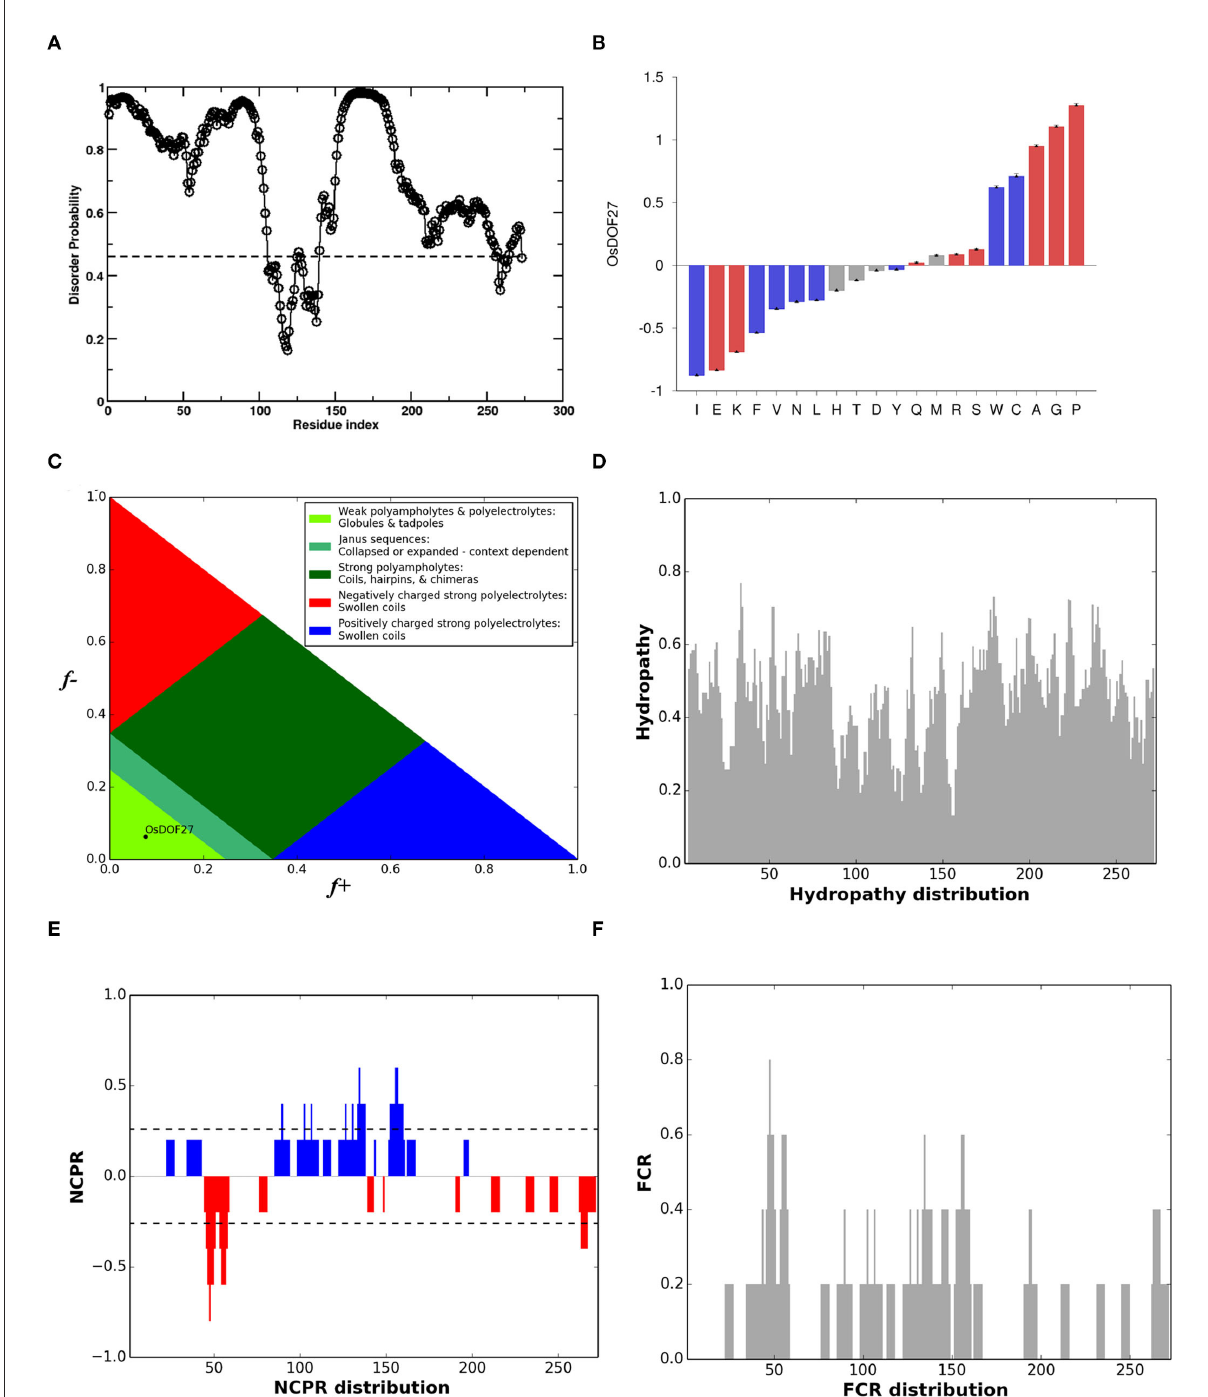
FIGURE2 (A) Graph represents a prediction of disorder regions present in the protein sequence of OsDOF27 based on the amino acid composition. Calculations were performed using the database of Protein Disorder (DisProt) software. A score over 0.5 indicates a high probability of disorder. (B) Depiction of compositional bias of OsDOF27 to show enriched or depleted aa of OsDOF27 against the SwissProt52 database. The amino acid composition was color-coded for disorder and sorted by the difference observed. The red and blue color bars indicate the disordered and ordered promoting amino acid, respectively, while the gray color-coded bar represents the neutral amino acid. (C) Analysis for diagram of states which represent the position of protein in graph drawn between the fraction of positive and negative charge, (D) Hydropathy plot (based on Kyte-Doolittle hydrophobicity scale ), (E) NCPR (net charge per residue), (F) FCR (fraction of charged residue) of OsDOF27 protein